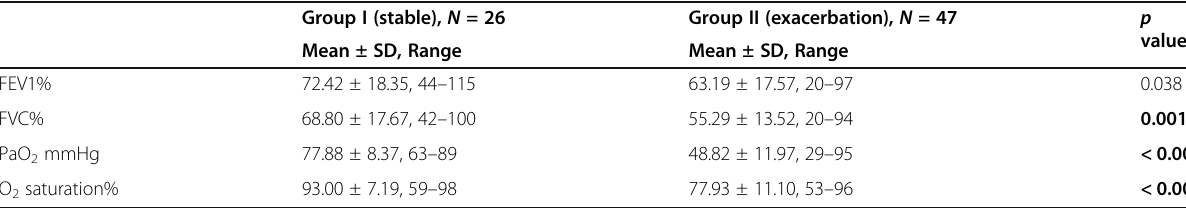
Table 4 Functional parameters of diseased groups Group I (stable), N = 26 Group II (exacerbation), N =